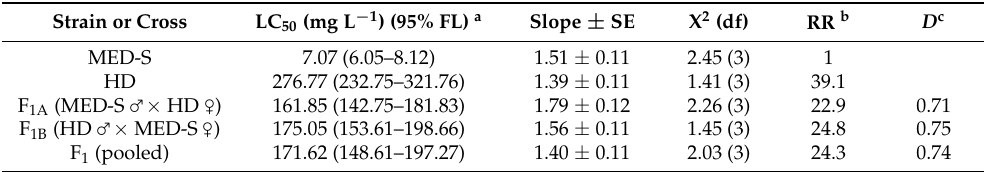
Table 5. Efficacy of afidopyropen in susceptible (MED-S) and resistant (HD) strains of B. tabaci and their F 1 progeny from reciprocal